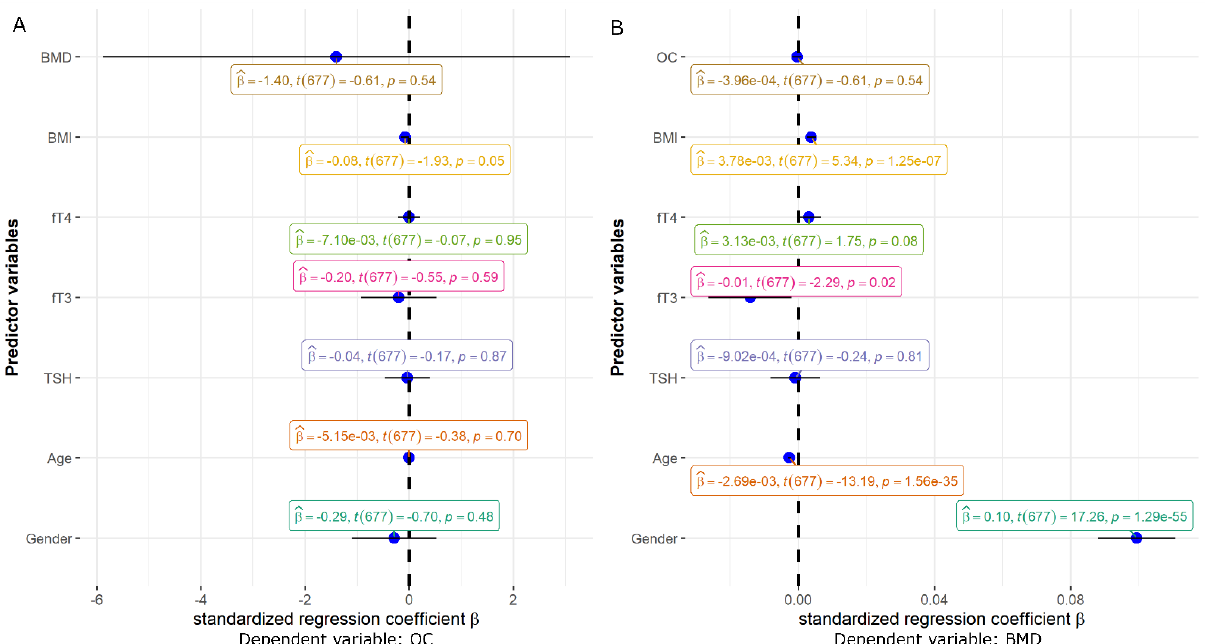
Figure 2. ( A ) Effect sizes and 95% confidence intervals obtained from the linear regression analysis for the association of gender, age, TSH, fT3, fT4, BMI, and BMD with OC plasma levels. ( B ) Effect sizes and 95% confidence intervals obtained from the linear regression analysis for the association of gender, age, TSH, fT3, fT4, BMI, and OC with BMD. Statistically significant predictor variables are the lines that do not intersect with the vertical line at 0. If the lower limit of the confidence interval is above 0, the association is positive, whereas if the upper limit of the confidence interval is below 0, the association is negative.